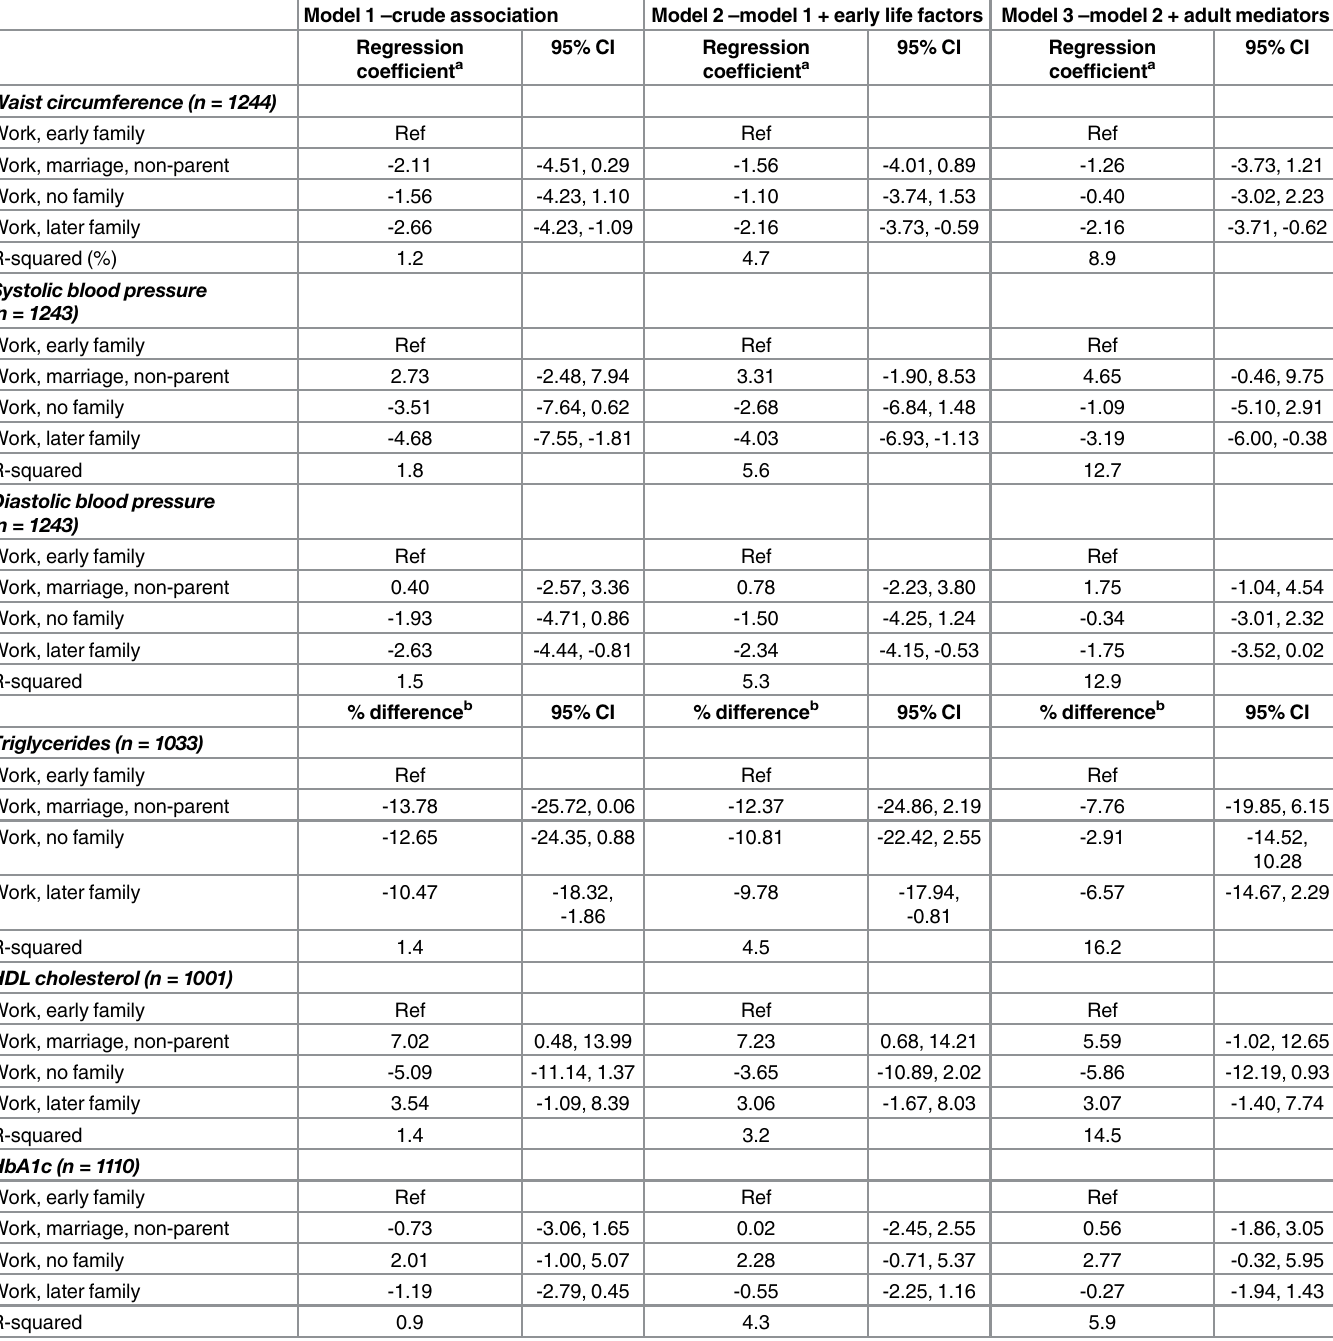
Table 2. Associations Between Work-Family Life Courses and Metabolic Markers at Age 53 for